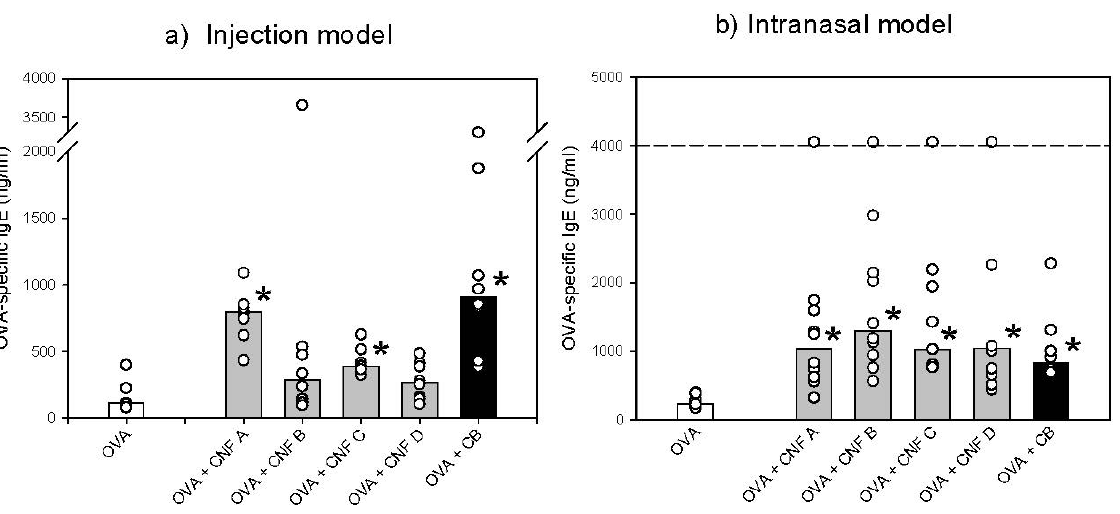
Figure 7. ( a ) Serum levels of OVA-specific IgE on day 26 after subcutaneous injection; and ( b ) intranasal application of OVA alone or together with the four different CNFs, following an allergen booster. Values for individual mice (circles) and median values (columns) for groups of eight and ten mice, respectively, are shown. The dotted line indicates the upper detection limit for the ELISA assay. * Denotes a statistically significant difference compared to the OVA group (p < 0.001), determined by pair-wise comparisons by Tukey’s post hoc test following positive ANOVAs on log-transformed IgE